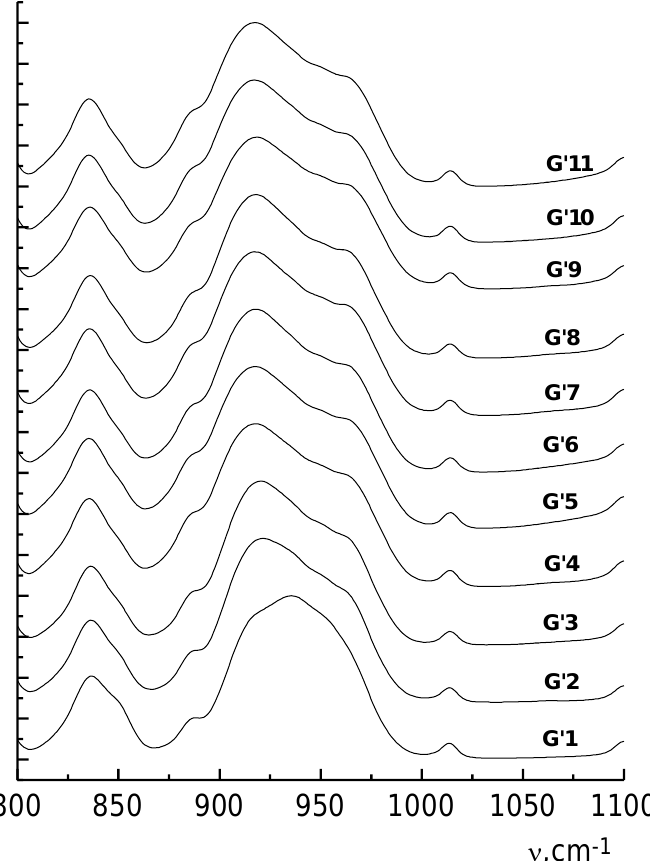
Figure 5. Modification of the contour of the ν(PO) and ν(PN) bands in the IR spectra of the generation series of phosphorus-containing dendrimers.